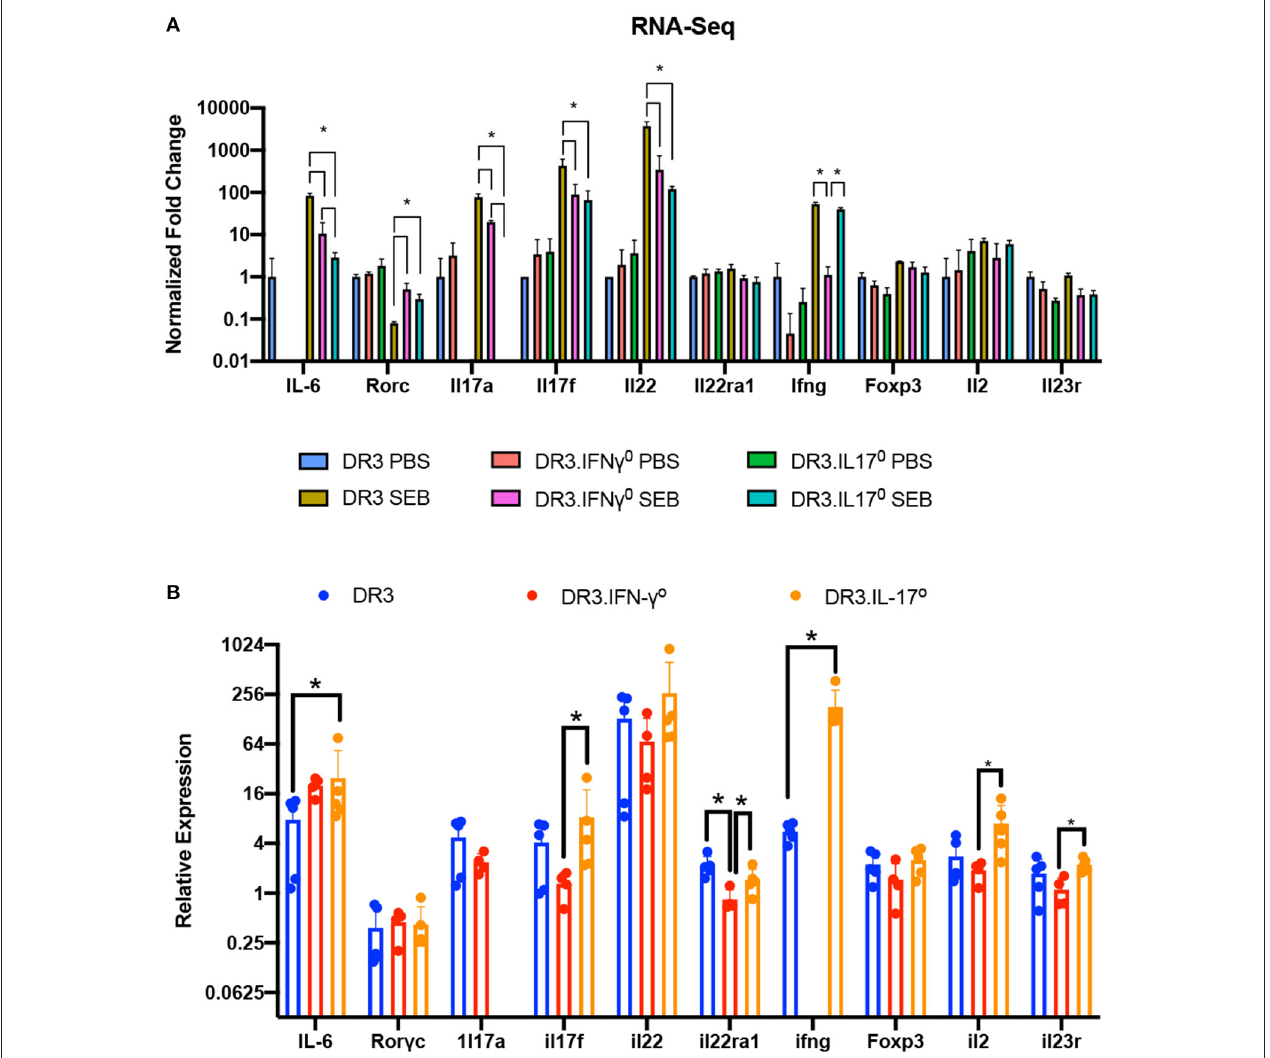
FIGURE 6 | Validation of RNA-Seq gene expression changes via RT-qPCR. (A) Fold changes in the expression of a subset of genes involved in immune responses as determined by RNA-seq. (B) The expression levels of genes shown in panel A were further confirmed by RT-qPCR using the 11 CT method. Each bar represents mean ± SE from 4 to 5 mice. * p <